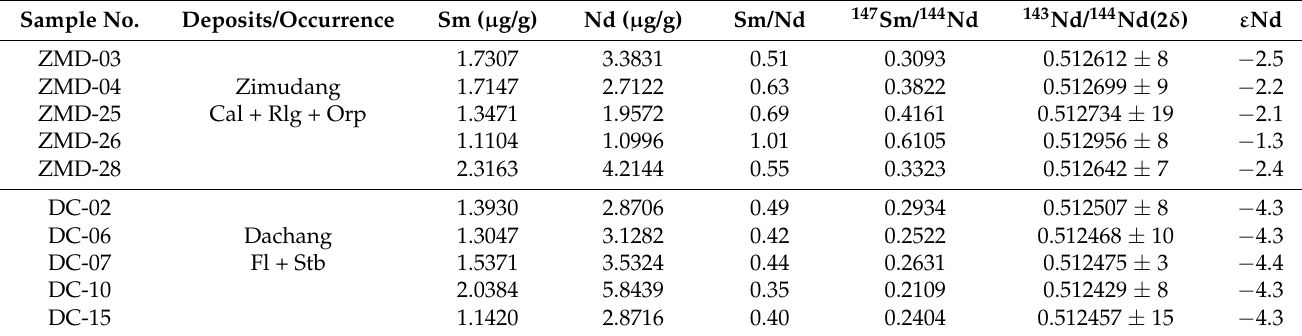
Table 2. Sm–Nd isotopic compositions of the calcite and fluorite